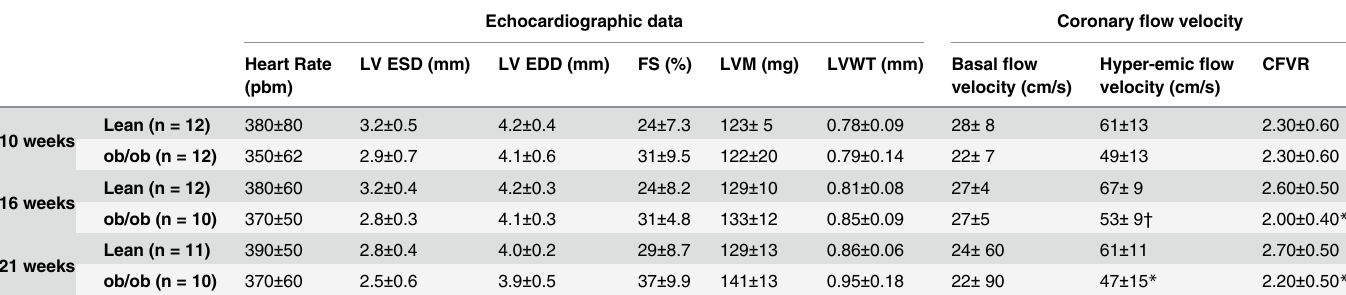
Table 2. Echocardiographic data and coronary flow velocity in 10, 16 and 21 weeks old lean controls and leptin-deficient mice. Echocardiographic